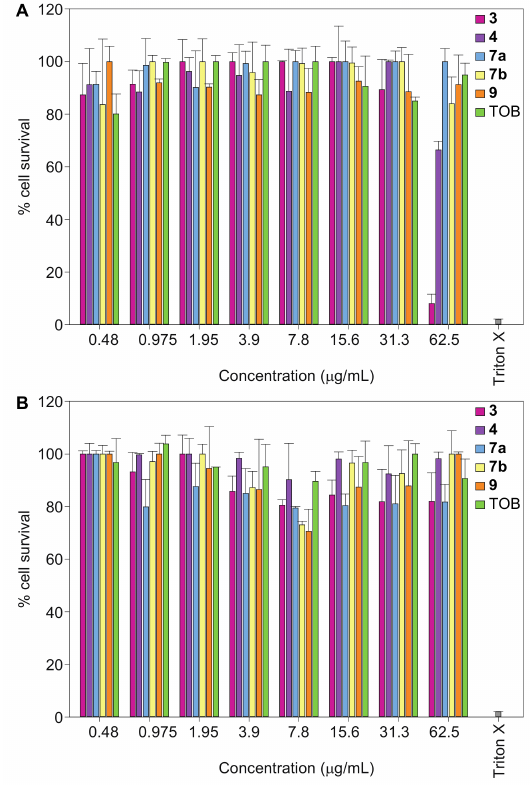
Figure 2. The mammalian cell cytotoxicity of TOB and its derivatives 3 , 4 , 7a , 7b , and 9 against ( A ) the BEAS-2B cell line and ( B ) the A549 cell